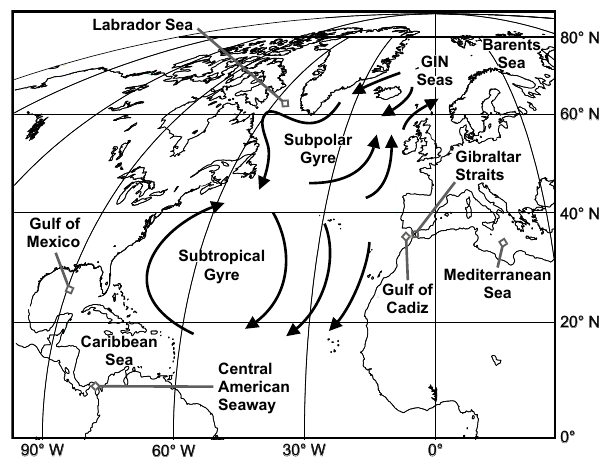
Fig. 2. Map of the North Atlantic region marked with key geograph- ical areas discussed in the text. Schematic representations of the modern North Atlantic subtropical and subpolar ocean gyre circu- lations are also